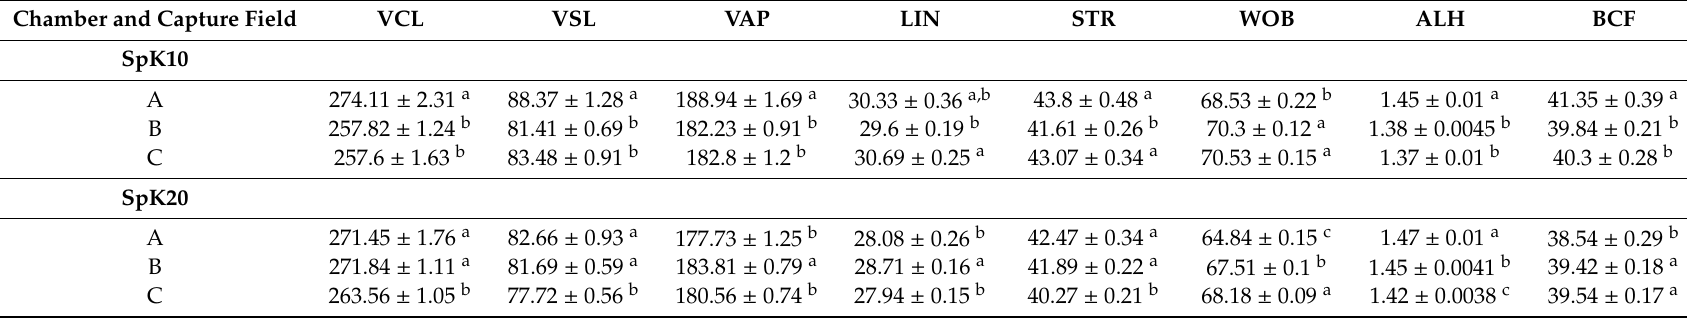
Table 5. Mean ( ± SEM) of sperm kinetic parameters (VCL, VSL, VAP, LIN, STR, WOB, ALH and BCF) in donkey semen in reusable chamber Spermtrack ® (SpK) 10 and 20 µ m